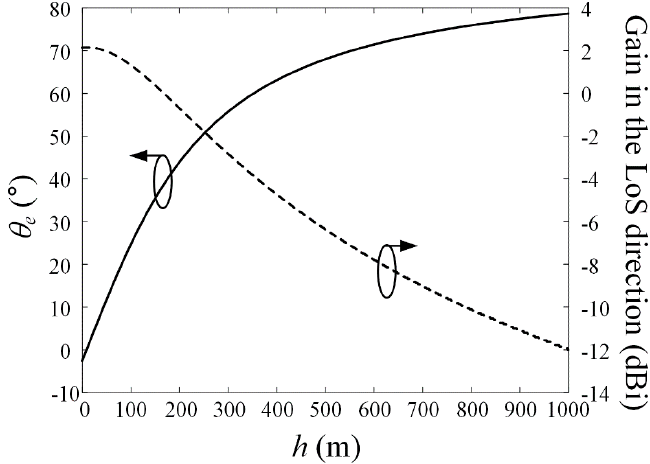
Figure 8. Elevation angle and the gain according to the rocket’s altitude.